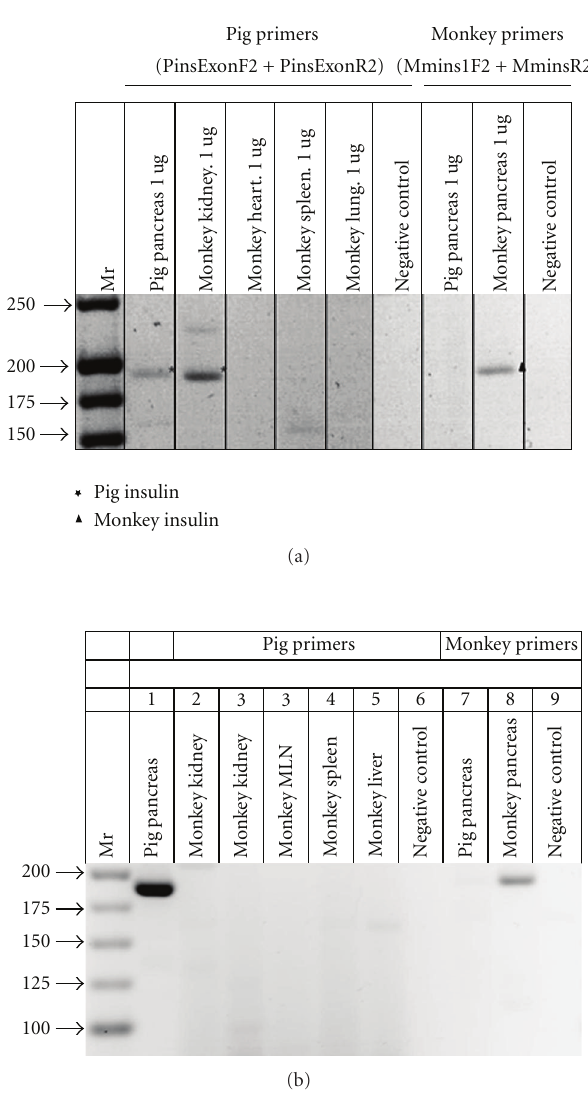
Figure 3: RT-PCR: (a) shown left to right are DNA molecular weights (Mr); amplification of bands using primers specific for porcine proinsulin from 1ug RNA extracted from pig pancreas or from a rhesus macaque (monkey) transplanted with E28 pig pancreatic primordia in mesentery followed by implantation of porcine islets in the renal subcapsular space: kidney, heart, spleen, lung, a negative control for porcine-specific primers (no RNA); amplification of bands using primers specific for monkey proinsulin from 1ug of pig pancreas RNA; monkey pancreas; a second negative control for macaque-specific primers. (b) Shown left to right are DNA molecular weights (Mr); amplification of bands using primers specific for porcine proinsulin from 2ug RNA extracted from pig pancreas or from a rhesus macaque (monkey) implanted with porcine islets in the renal subcapsular space with no previous transplantation of E28 pig pancreatic primordia: kidneys, mesenteric lymph node (MLN) spleen, liver, a negative control for porcine-specific primers (no RNA); amplification of bands using primers specific for monkey proinsulin from 2ug of pig pancreas RNA; monkey pancreas and a second negative control for macaque- specific primers. Pig primers amplify a 193bps band. Monkey primers amplify a 199 bps band. Reproduced with permission from Organogenesis